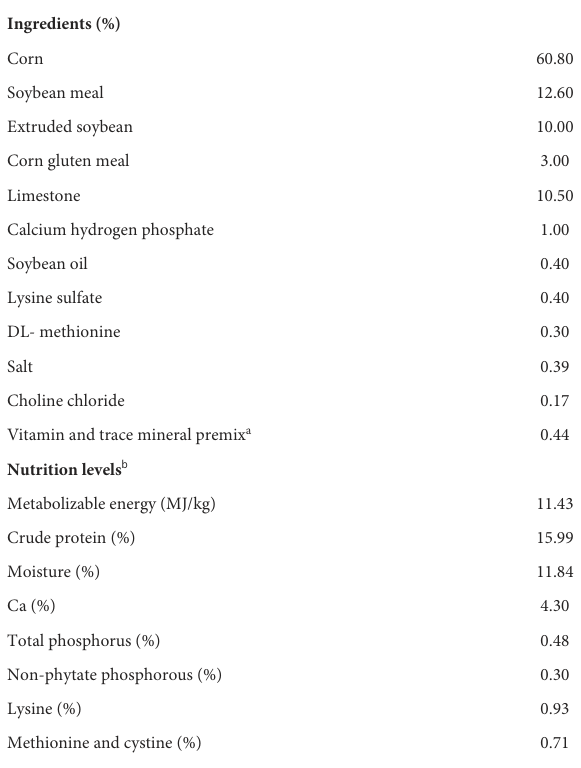
TABLE 1 Formulation and composition of the basal